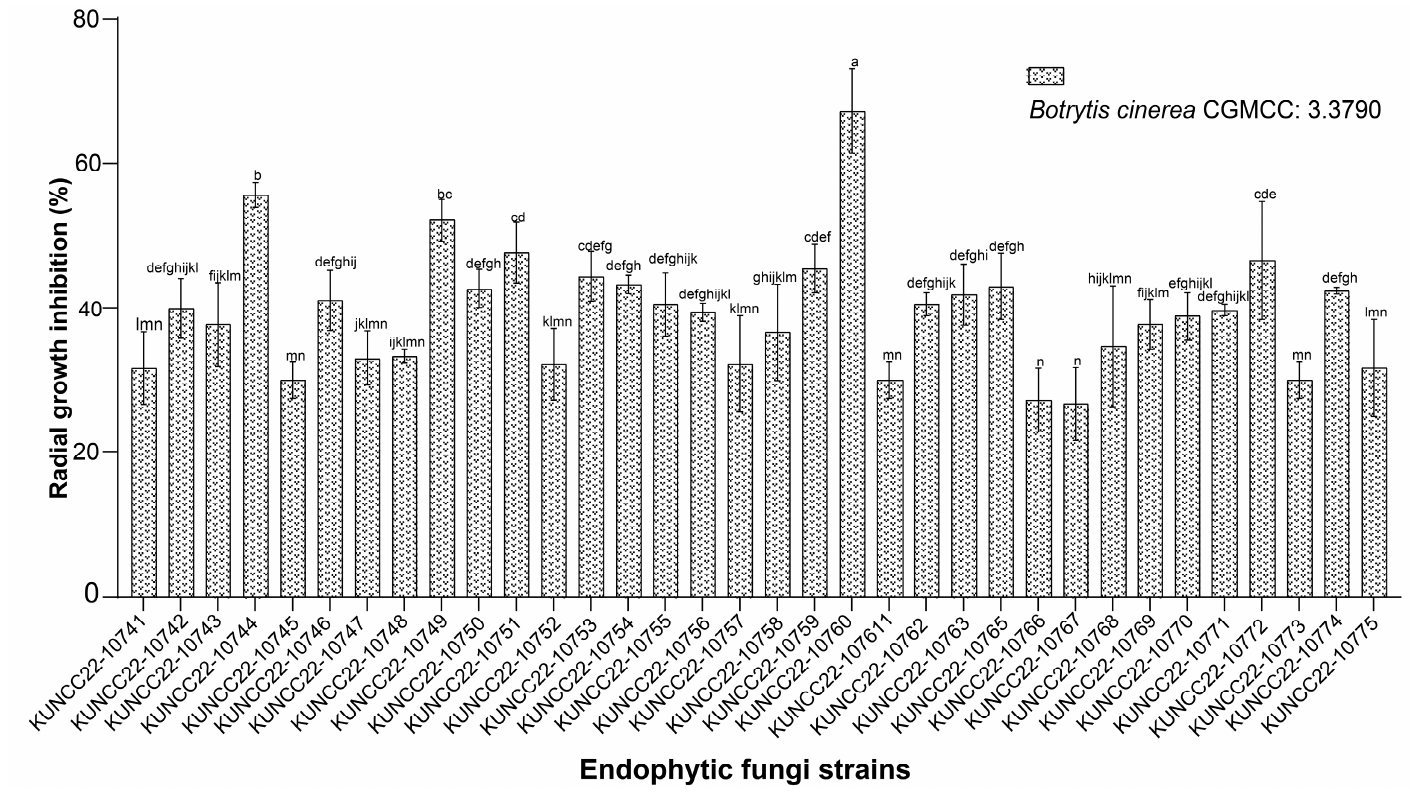
Figure 8. Inhibition rates of different fungal endophytes to fungal pathogen Botrytis cinerea (GCMCC: 3.3790). The bars denoted by the same letter are not significantly different from each other.